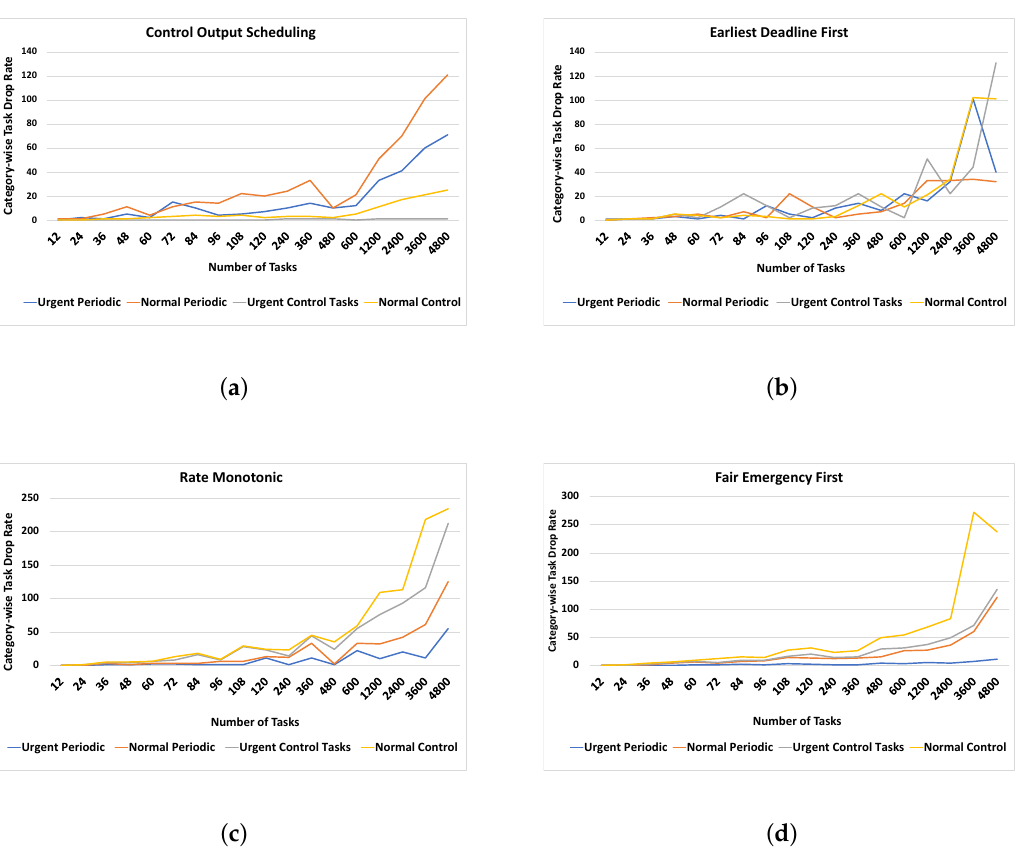
Figure 10. Effect of task dropping rate on increasing number of tasks: ( a ) control output scheduling, ( b ) earliest deadline first, ( c ) rate monotonic, and ( d ) fair emergency first.